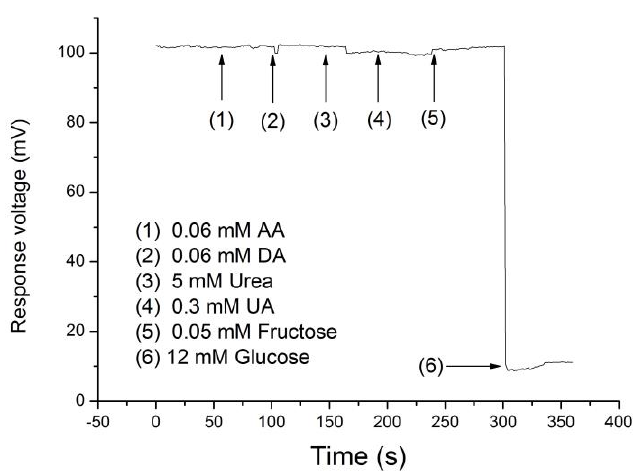
Figure 11. Interference e ff ects of the potentiometric arrayed glucose biosensor based on Nafion-GOx / GO / AZO upon the addition of ascorbic acid (AA) (0.06 mM), dopamine DA (0.06 mM), urea (5 mM), uric acid (UA) (0.3 mM), fructose (0.05 mM) and glucose (12 mM).